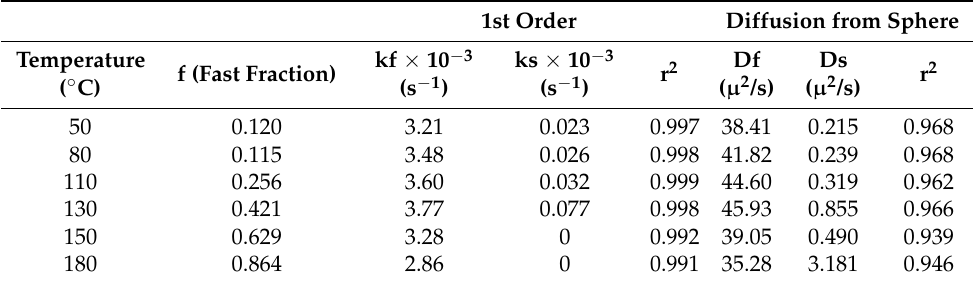
Table 6. Parameters estimated for each desorption data, fitted with a first-order and a diffusion- based model. 1st Order Diffusion from Sphere